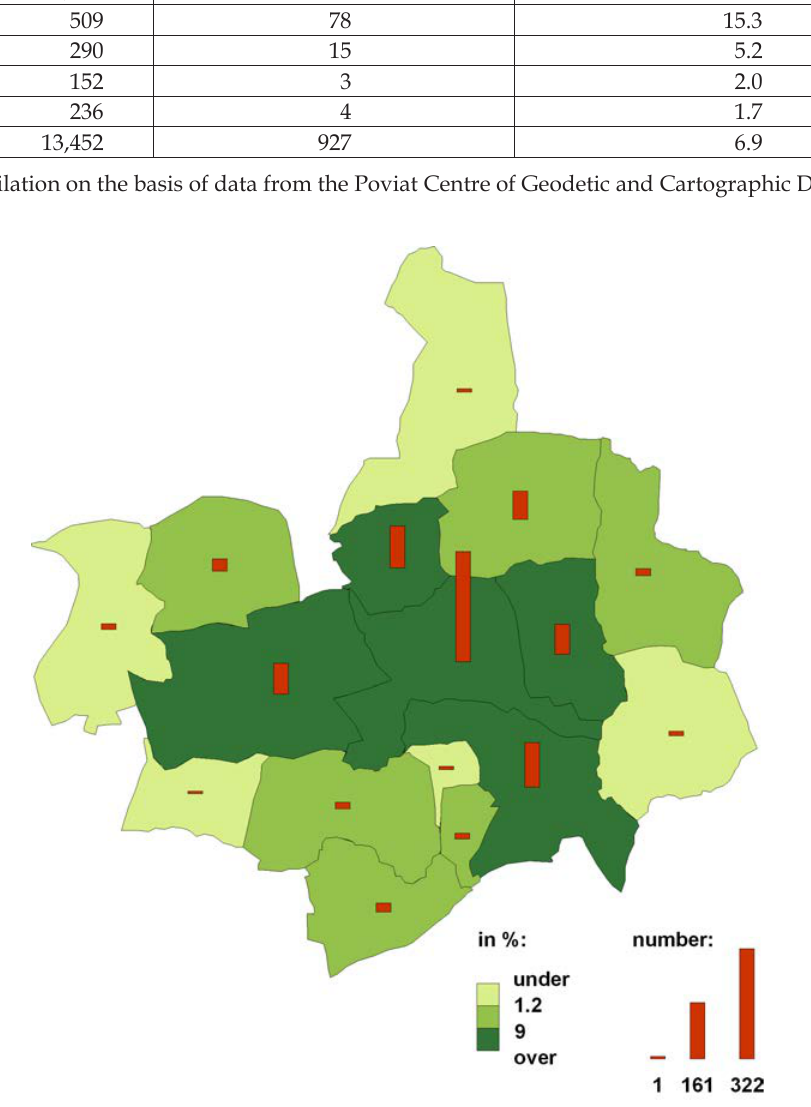
Fig. 2. Built-up housing lots with agricultural land, 2014 (Rokietnica commune in the system of geodetic districts). in